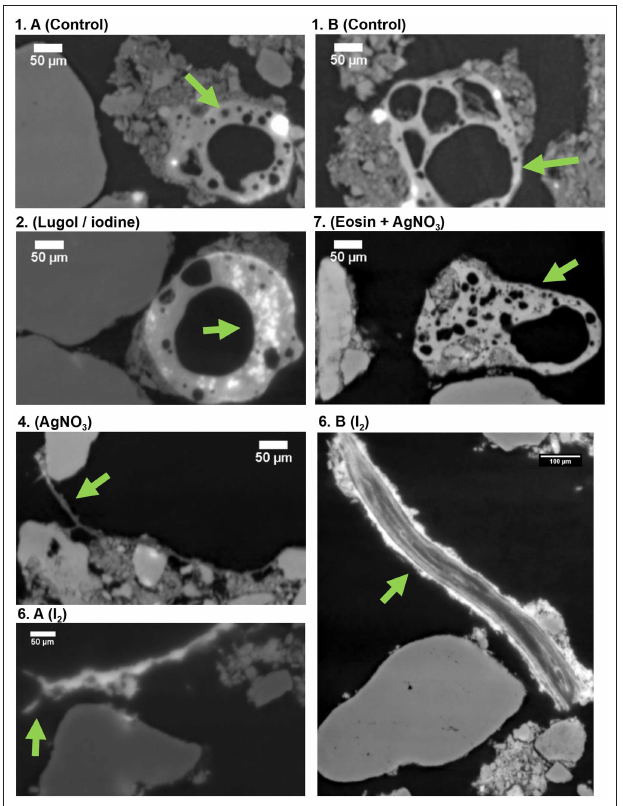
FIGURE 3 | Reconstruction images (X-Y-Z) of the K-edge synchrotron based X-ray tomographies for the soil samples stained with (1) I 2 and (2) AgNO 3 . The colors highlight the location of organic matter stained by the contrast agents (in the virtual models green color for iodine and yellow for Ag). Details in Supplementary Figure 1